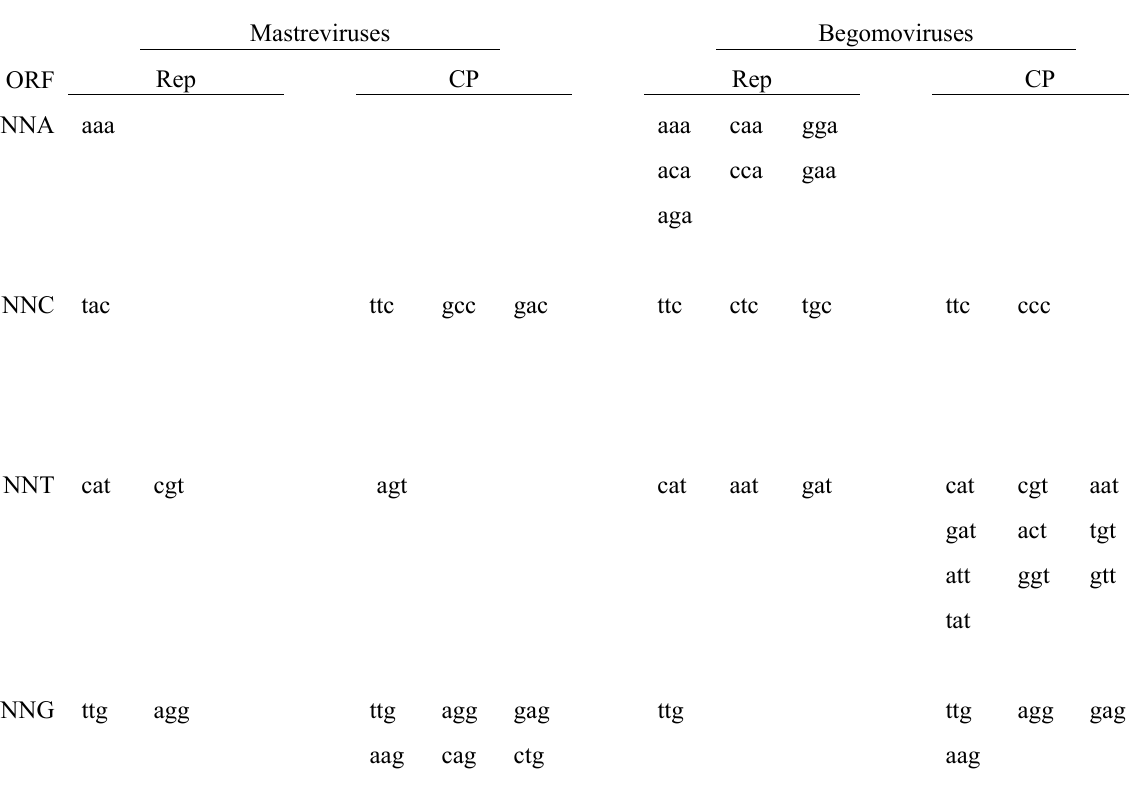
Table 4. Preferred codons in mastrevirus and begomovirus Rep and CP genes.